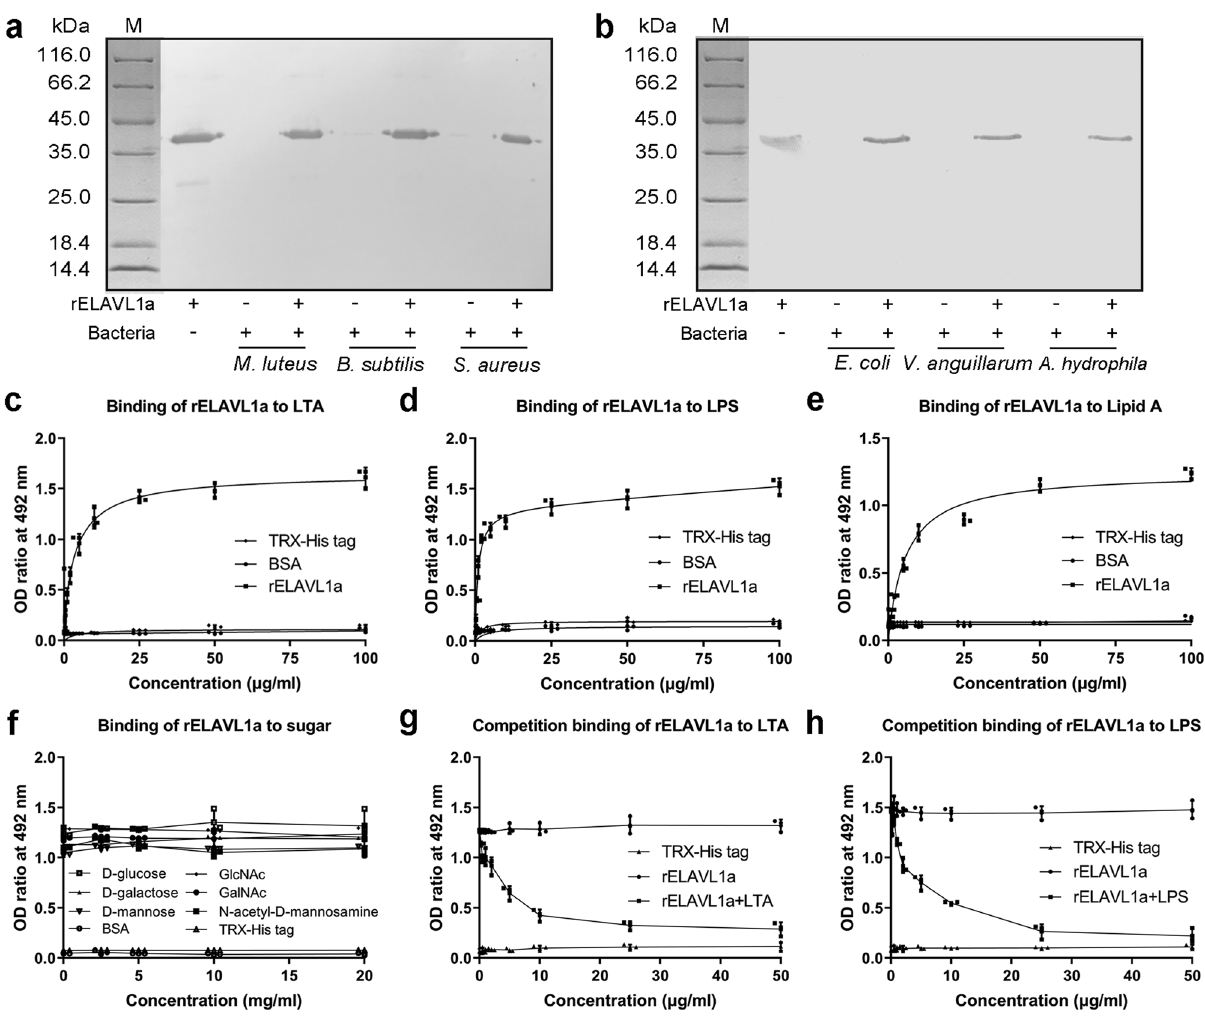
Fig. 3 Binding of rELAVL1a to Gram-positive and Gram-negative bacteria, LTA, LPS, and lipid A. a , b Western blotting about interaction of rELAVL1a with Gram-positive ( a ) and Gram-negative ( b ) bacteria. Lane M, marker; lane 1, puri fi ed rELAVL1a; lane 2, 4 and 6, M. luteus , B. subtilis and S. aureus ( a ) or E. coli , V. anguillarum and A. hydrophila ( b ) incubated in the presence of rELAVL1a; lane 3, 5, and 7, M. luteus , B. subtilis and S. aureus ( a ) or E. coli , V. anguillarum and A. hydrophila ( b ) incubated in the absence of rELAVL1a. c , d , e Interaction of rELAVL1a with LTA ( c ), LPS ( d ), Lipid A ( e ) revealed by ELISA. f Effects of various sugars on the interaction of rELAVL1a with LPS. g , h Interaction of rELAVL1a with LPS was inhibited by LTA ( g ) and LPS ( h ), the fi nal concentration of rELAVL1a was 25 μ g/ml. Each point in the graph represents the mean ± S.D. ( n = 3). The data are from three independent experiments performed in triplicate. The bars represent the mean